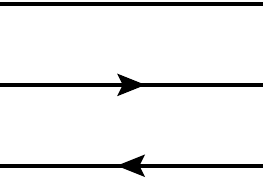
Figure 8 . The propagators for the neutral-wino (cid:12)eld w 0 and the charged-wino (cid:12)elds w + and w (cid:0) . The Feynman rules are i(cid:14) ab = [ E (cid:0) p 2 = (2 M ) + i(cid:15) ] for the neutral-wino propagator and i(cid:14) ab = [ E (cid:0) p 2 = (2 M ) (cid:0) (cid:14) + i(cid:15) ] for the charged-wino propagators, where a and b are Pauli spinor indices. are turned o(cid:11) by setting (cid:11) = 0, ZREFT can be de(cid:12)ned as a systematically improvable ef- fective (cid:12)eld theory obtained through deformations of a renormalization-group (cid:12)xed